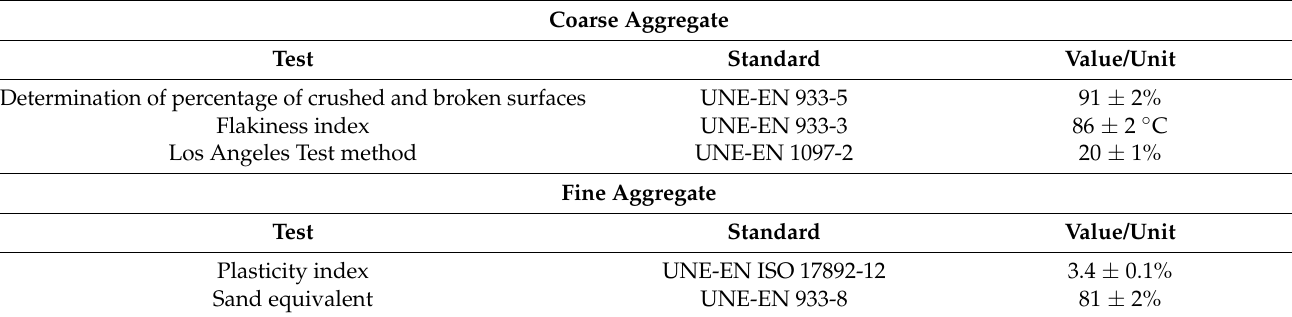
Table 7. Tests of the coarse aggregate and fine aggregate of RAP.